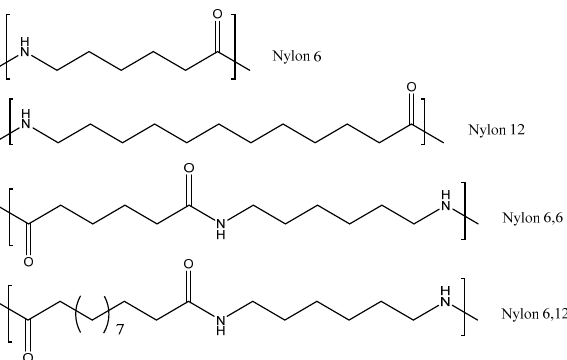
Figure 1. Structure of common polyamide polymers used in the fishing industry.